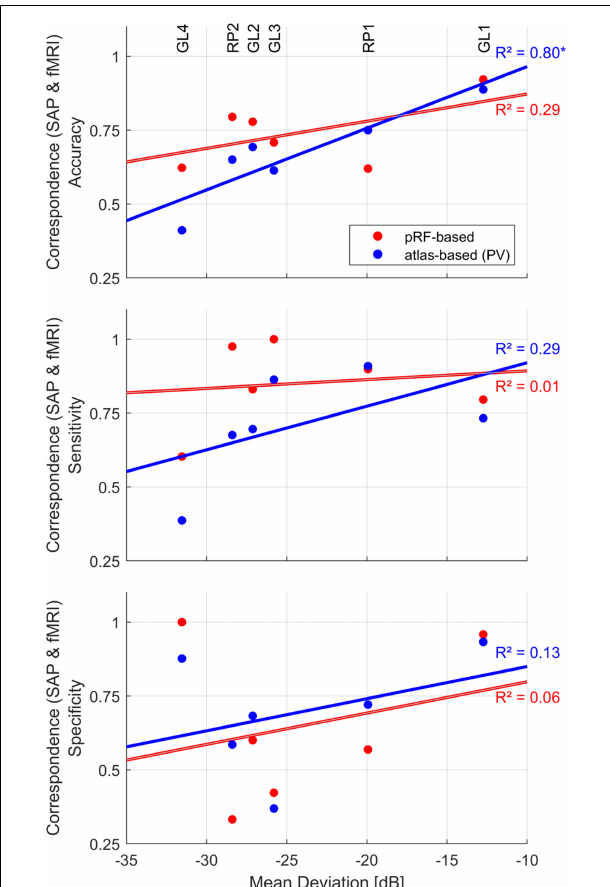
FIGURE 6 | Dependence of fMRI-SAP correspondence measures [pRF-based (red) and atlas-based PV (blue)] on mean deviation (MD) of the central 14 ◦ VF. Patient-specific measures are plotted as scatter-dot plots. Solid lines depict the best fitting regression. The strength of the association was evaluated as coefficient of determination (linear regression model); “*” indicates a significant p